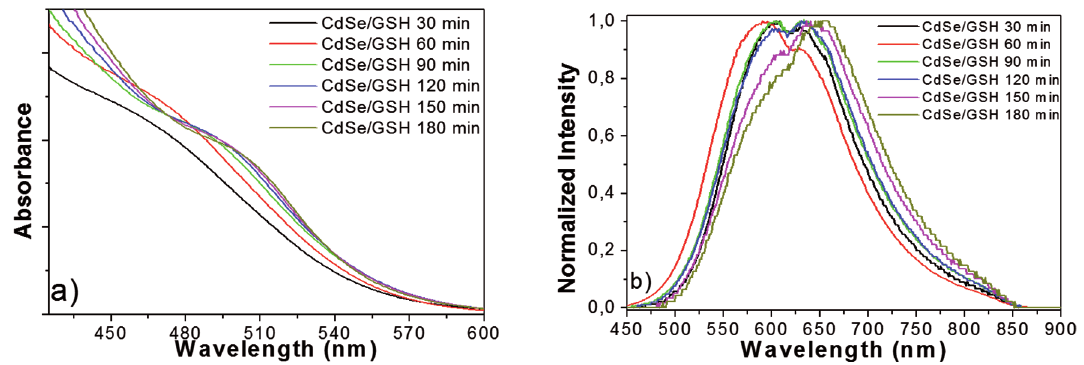
Figure 3: UV-visible absorption a) and fluorescence b) spectra of CdSe/GSH QDs at different reaction times.